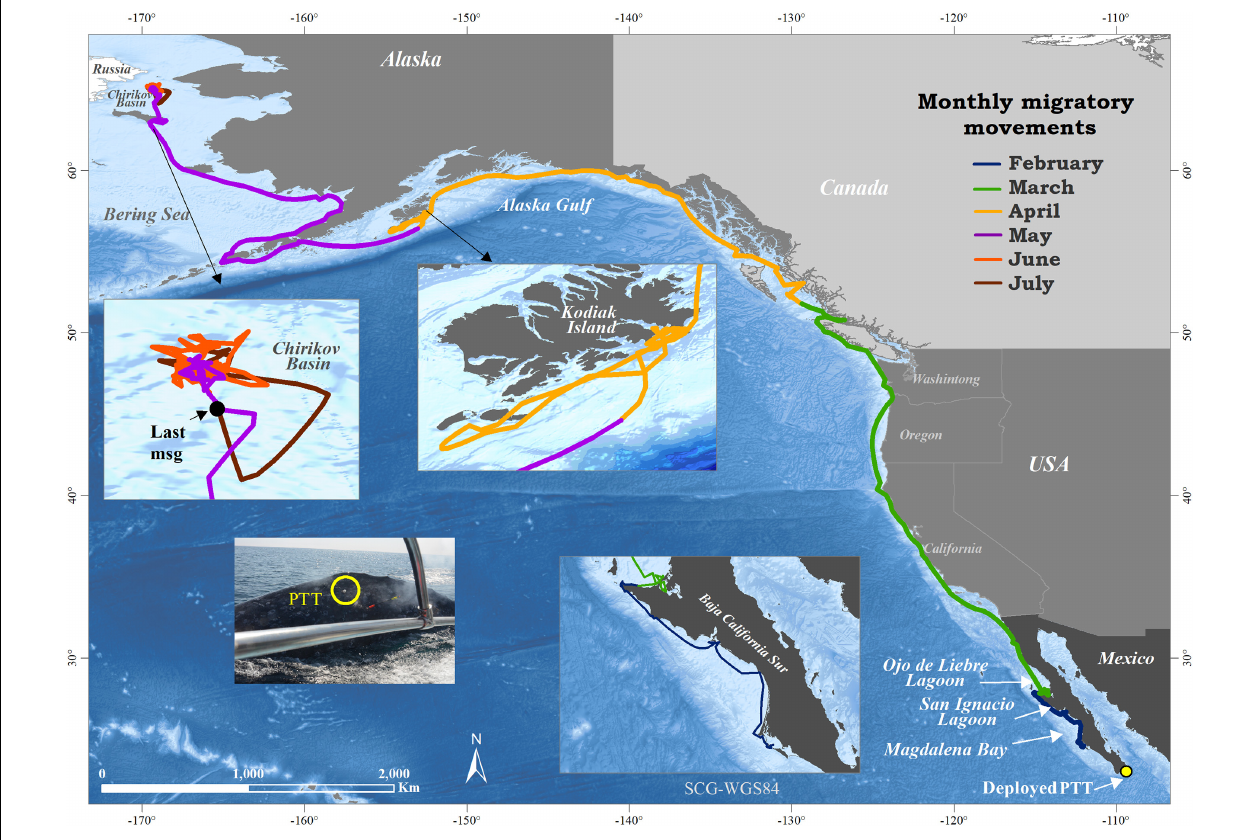
FIGURE 1 | Movements of María, the gray whale tagged on February 12 at San Jose del Cabo, BCS, Mexico 2017, dividing by months.